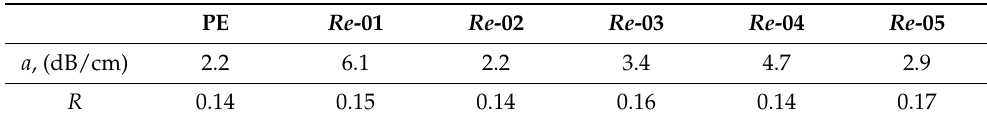
Table 16. Values of the specific radio absorption and reflection coefficients in the microwave range for rhenium-containing composites at a frequency of 30 GHz.